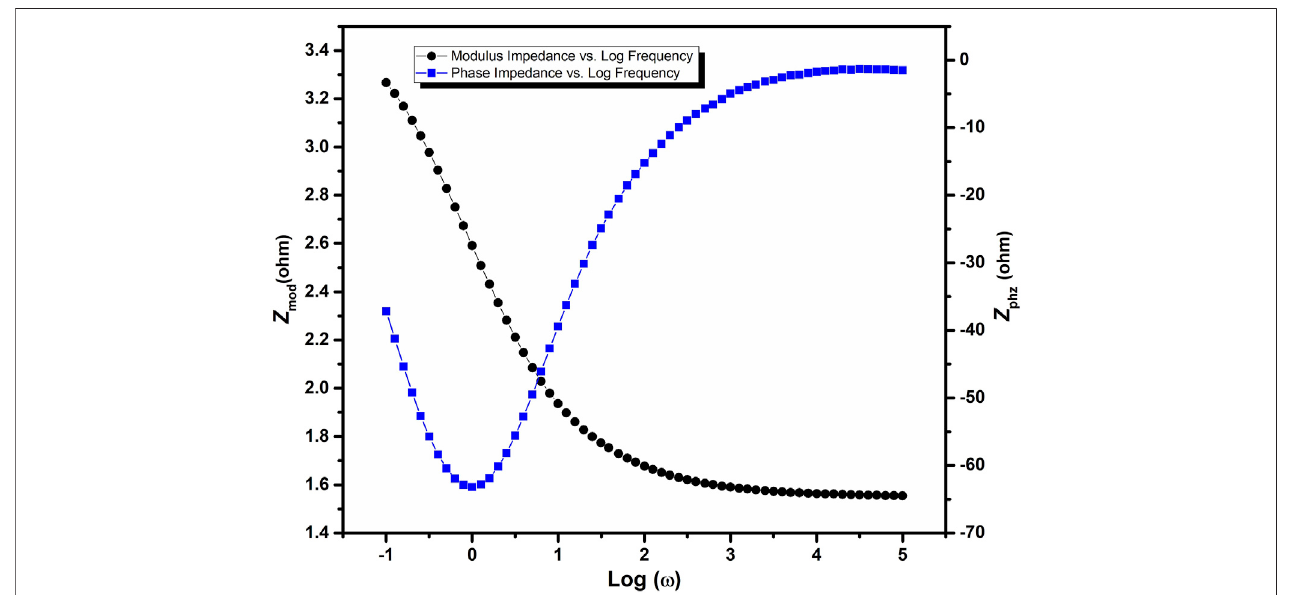
FIGURE 6 | Bode plot of EIS of the Mn 2 O 3 /graphene composite material.